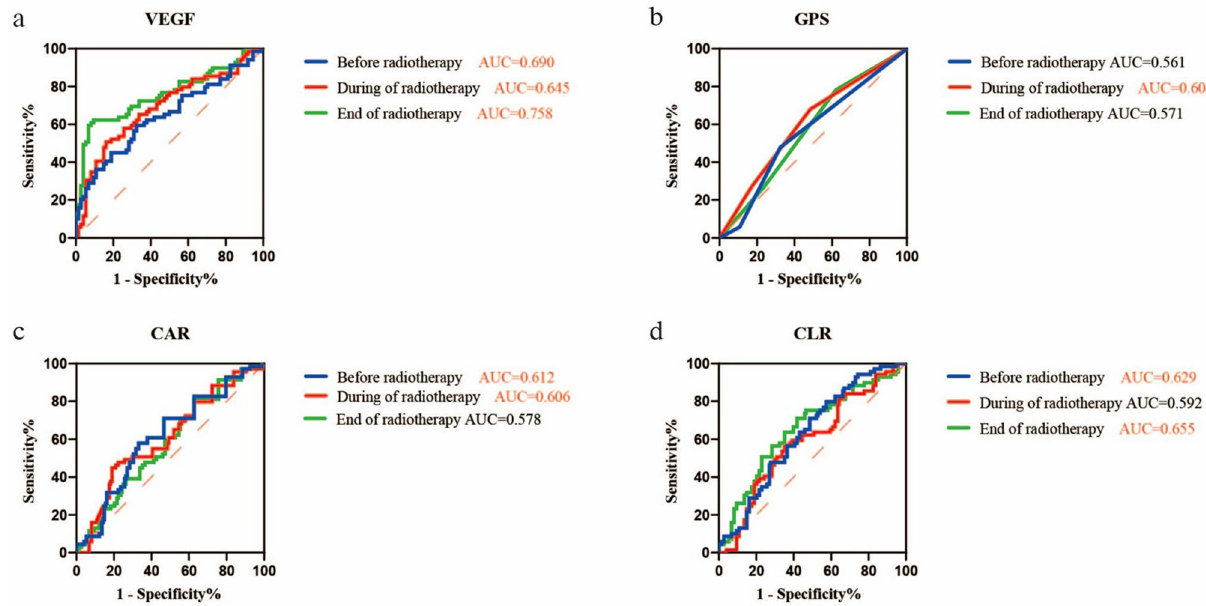
Figure 2. The predictive ability of VEGF and the inflammatory biomarkers were compared by ROC curves. ( a ) The AUCs of VEGF before, during and end of radiotherapy were 0.690 (p < 0.0001), 0.645 (p = 0.003), 0.758 (p < 0.0001) respectively. ( b ) The AUCs of GPS before, during and the end of radiotherapy were 0.561 (p = 0.212), 0.604 (p = 0.031), 0.571 (p = 0.144) respectively. ( c ) The AUCs of CAR before, during and the end of radiotherapy were 0.612 (p = 0.021), 0.606 (p = 0.029), 0.578 (p = 0.106) respectively. ( d ) The AUCs of CLR before, during and the end of radiotherapy were 0.629 (p = 0.008), 0.592 (p = 0.057), 0.655 (p = 0.001) respectively. The red entries represent statistically